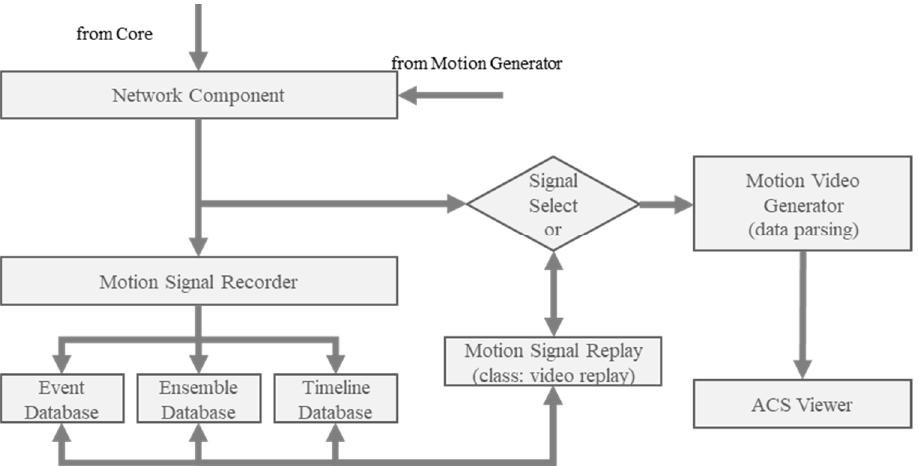
Figure 7. Components and data flow of visualization module. It receives data from the ACS core module and displays real-time situations or replays situations stored in the database through the ACS viewer.